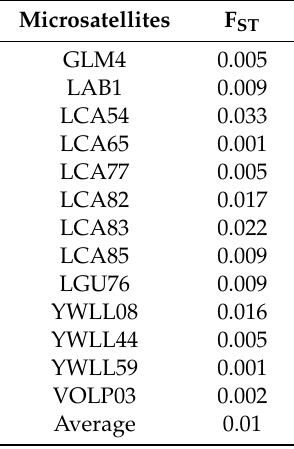
Table 4. F ST values of each microsatellite marker in the global population of llamas from the Camelid Germplasm